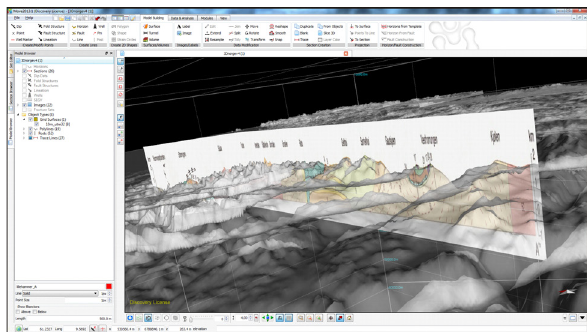
Figure 5: Profile and screenshot from 3D MOVE showing an example of the correspondence of the DEM with a hand drawn geological profile.